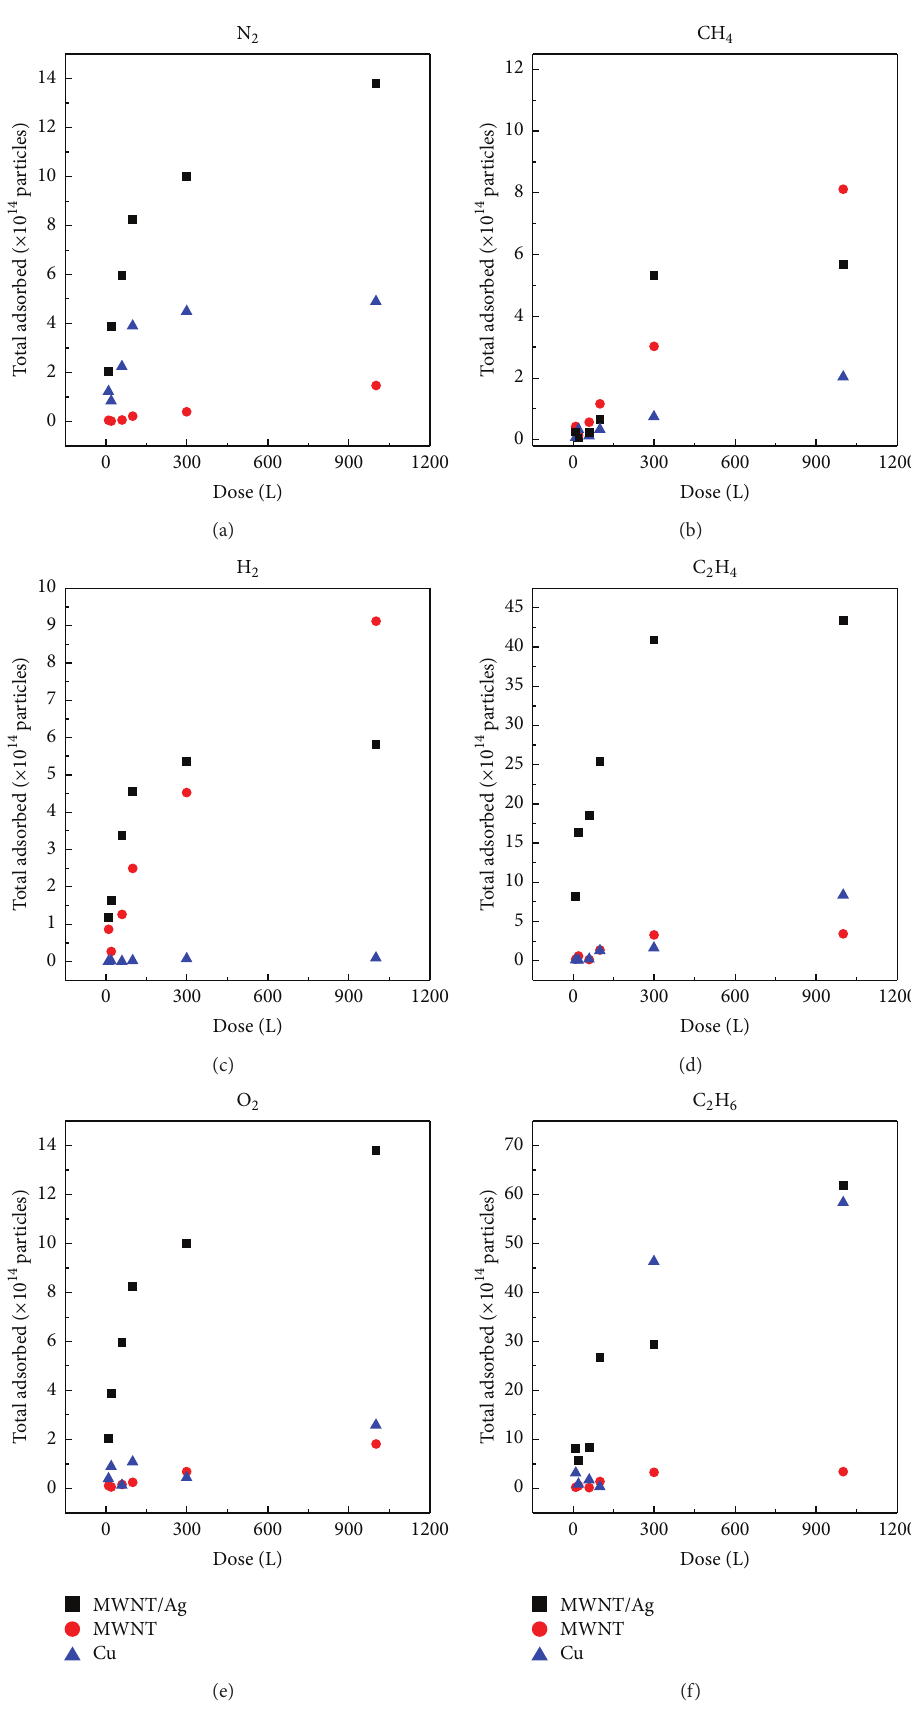
Figure 5: Molecular gases adsorbed on MWCNT, Ag/MWCNT, and copper cold head surface as a function of gases